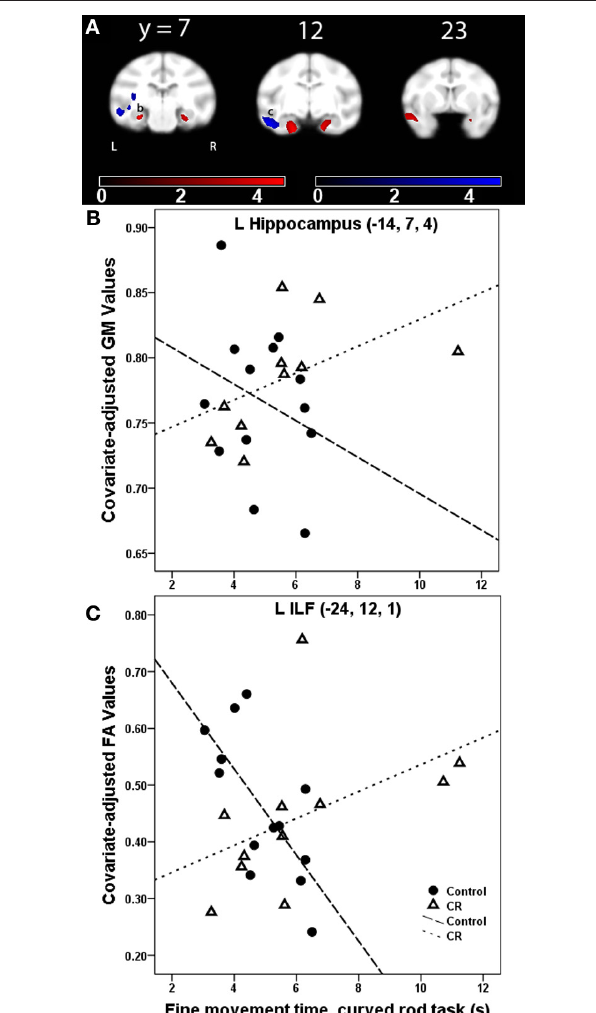
FIGURE 4 | (A) Statistical parametric map of the t -contrast displayed on coronal slices showing regions where the correlation between fine movement time (in seconds) during the learning phase of the curved rod task and gray matter (GM, red) and lower fractional anisotropy (FA, blue) differs as a function of dietary group (controls vs. CR). All comparisons include age, gender, dietary condition, and global signal variable as covariates. The probability threshold for each t -contrast was p < 0 . 005 (uncorrected). The color bars represent the value of the t -statistic. The left side of the brain is on the left in the images. (B) Scatter plot of the correlation between fine movement time (in seconds) during the learning phase of the curved rod task and regional GM at the left hippocampus, denoted as (b) in (A) . (C) Plot of the correlation between fine movement time (in seconds) during the learning phase of the curved rod task and FA in the left inferior longitudinal fasciculus [ILF, location denoted as (c) in panel (A) ].